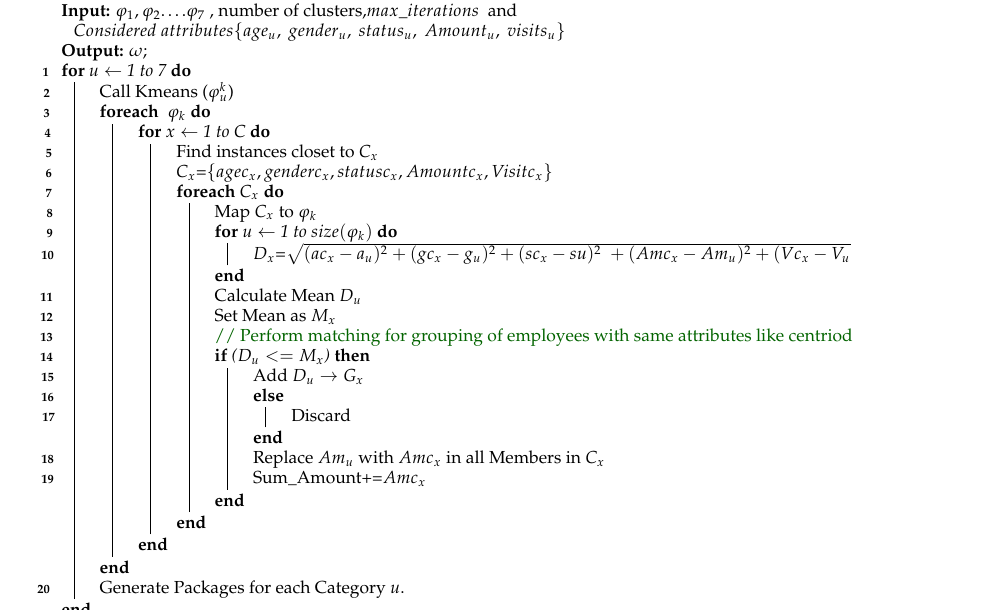
Algorithm 1: Need based Package generation using clustering and